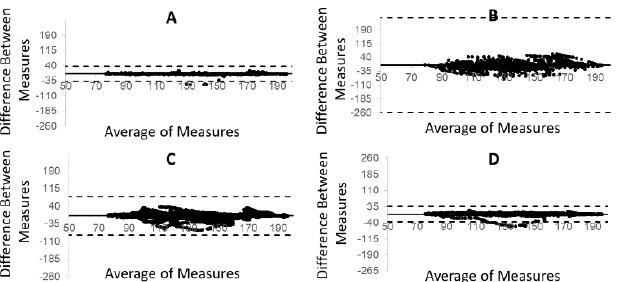
Figure 7. Bland–Altman plots of heart rate (bpm) during running activity for the ( A ) Apple Watch series 4, ( B ) Garmin Forerunner 735XT, ( C ) Jabra Elite earbuds, and ( D ) Scosche Rhythm 24 devices compared to the Polar H7. Dashed lines represent 95% limits of agreement.